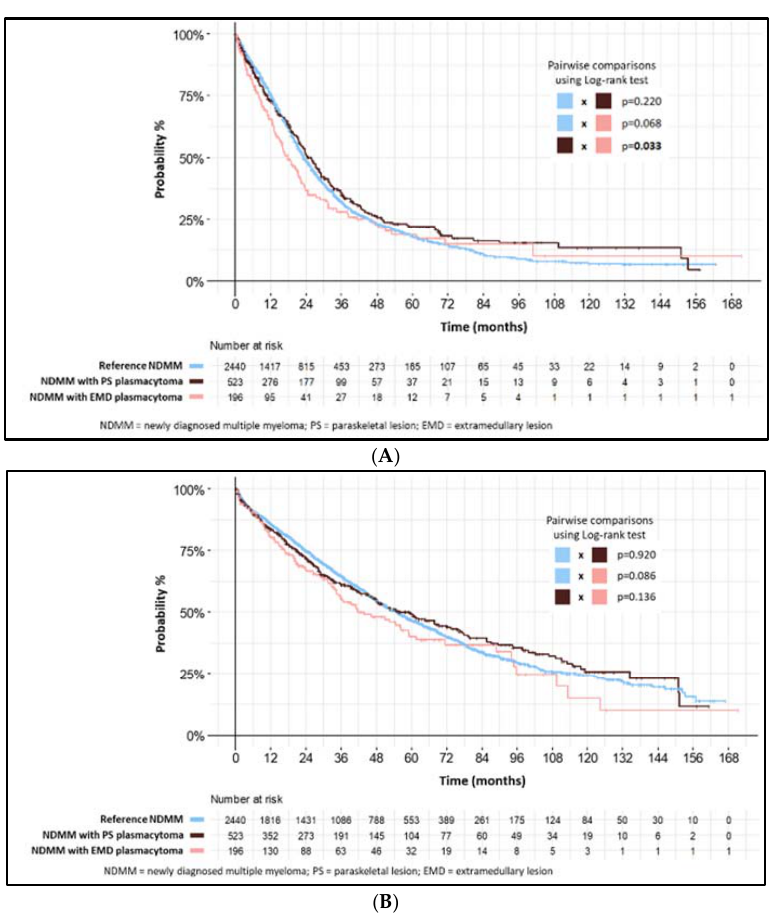
Figure 1. ( A ) PFS from 1st line—NDMM with plasmacytomas by type versus reference NDMM. ( B ) OS from 1st line—NDMM with plasmacytomas by type versus reference NDMM.